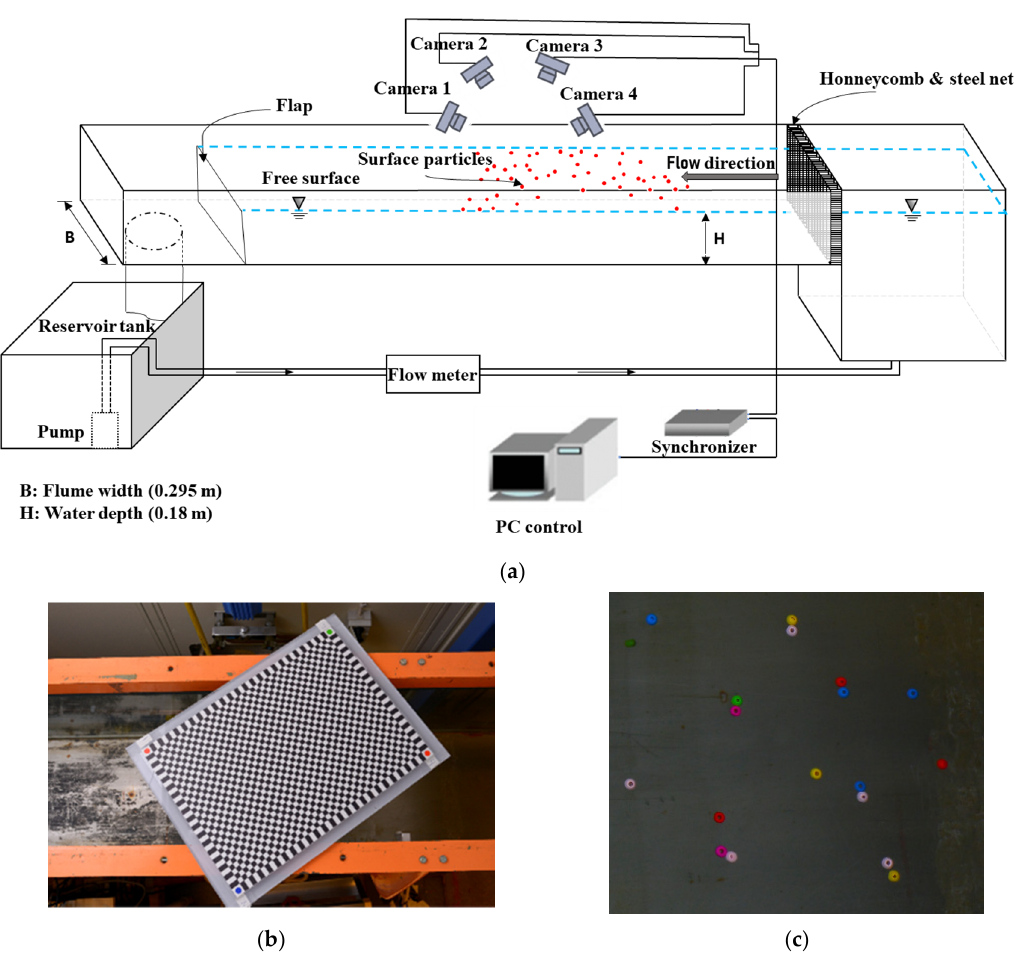
Figure 1. Laboratory flume measurement setup: ( a ) Sketch of the surface velocity measurement setup; ( b ) Checkerboard pattern for calibration; ( c ) Wooden bead particle.